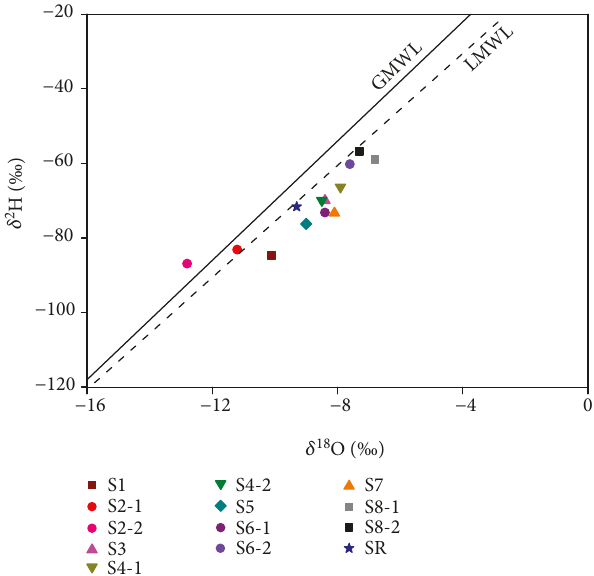
Figure 4: δ 2 H- δ 18 O plot for the hot spring samples in the Simao Basin.